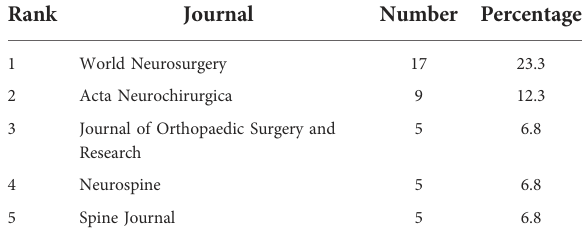
TABLE 3 Top 5 productive journals in the fi eld of unilateral biportal endoscopic spine surgery.